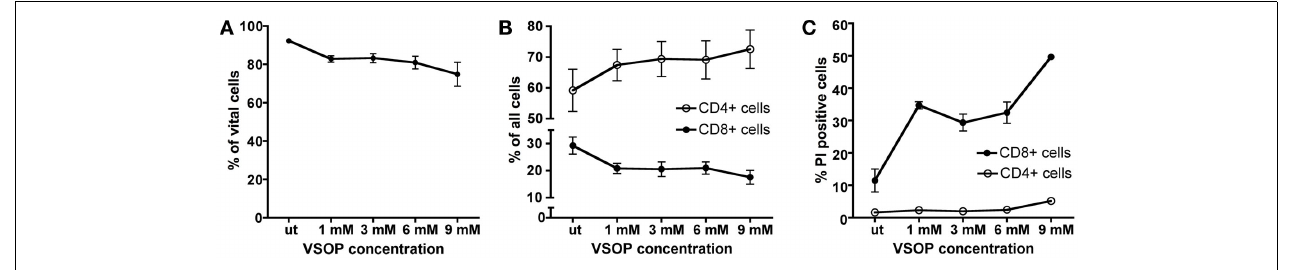
FIGURE 4 |We investigated the influence ofVSOP onT cell viability, differentiation and activation. The number of dead cells was quantified by FACS analysis using propidium iodide (PI). No significant reduction of cell viability was detected usingVSOP concentrations of 1–9mM Fe/ml in comparison to untreated cells (ut) (A) .The percentage of CD4 + cells within